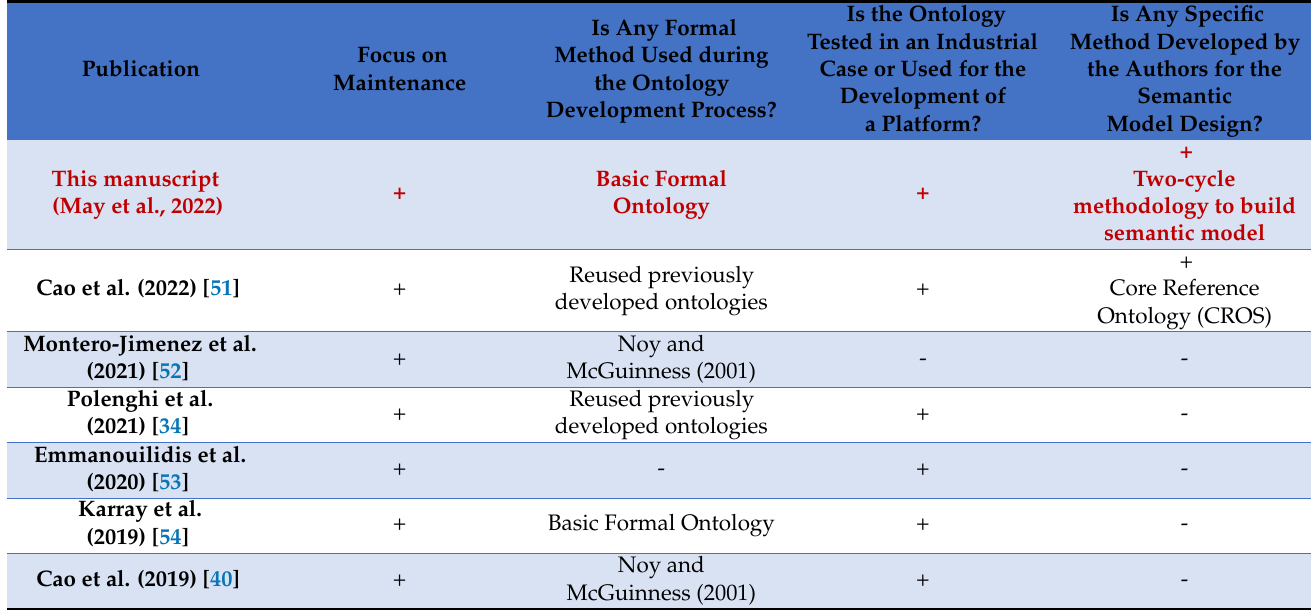
Table 1. Comparison of our research with relevant